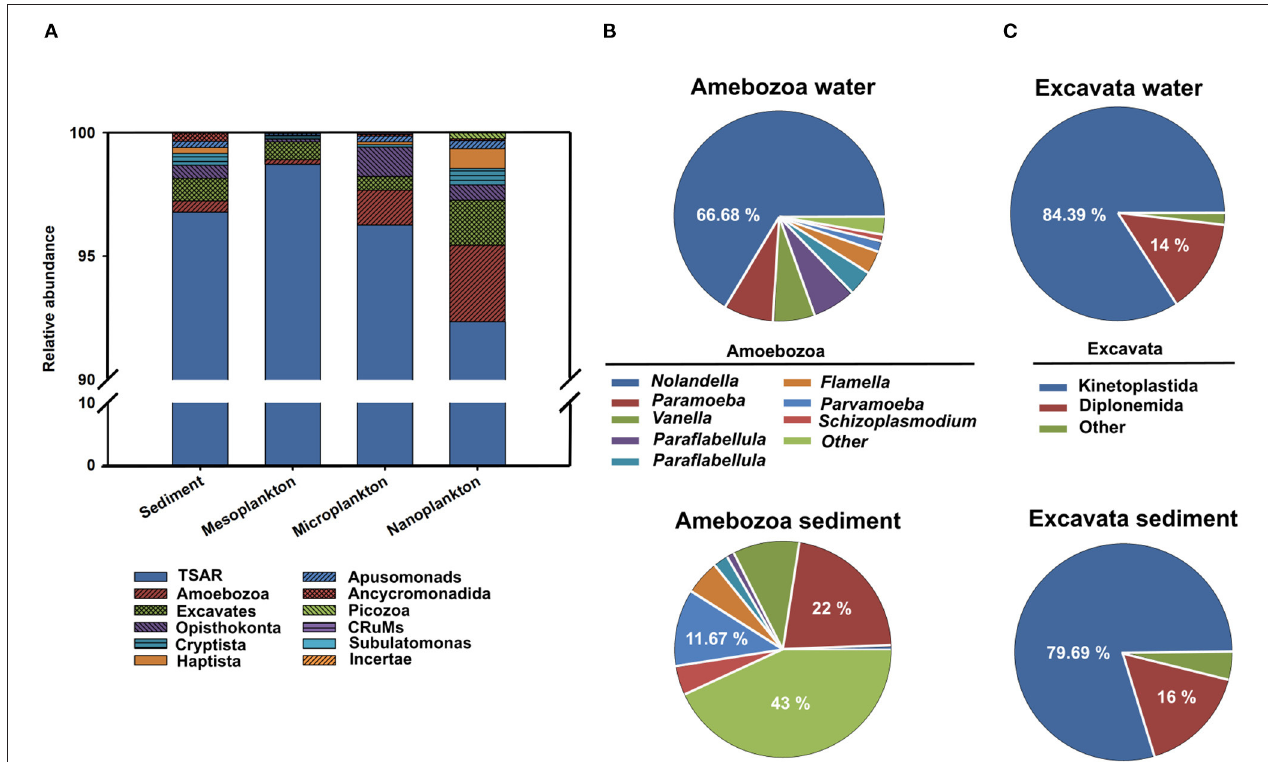
FIGURE 5 | The presence of protists classified according to Burki et al. (49) into four supergroups (Amebozoa, Excavata, TSAR, and a fourth group including other minor organisms) is represented. (A) Relative abundance of the different supergroups in sediment, meso-, micro-, and nanoplankton. Relative abundances of Amebozoa (B) and Excavata (C) in sediment and